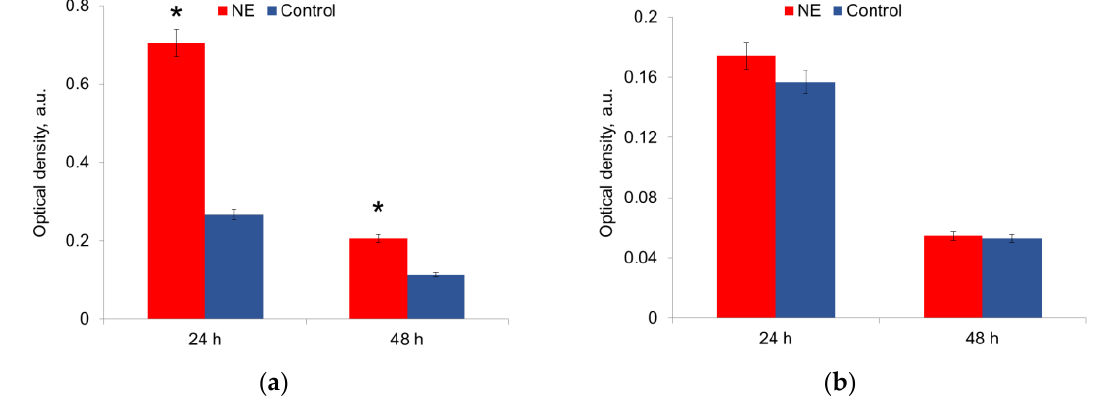
Figure 5. NE effect on metabolic activity of uropathogenic microorganisms E. coli ( a ) and S. aureus ( b ) in biofilms. The data of MTT-assay are present. * — statistically significant differences in comparison with the control without NE.